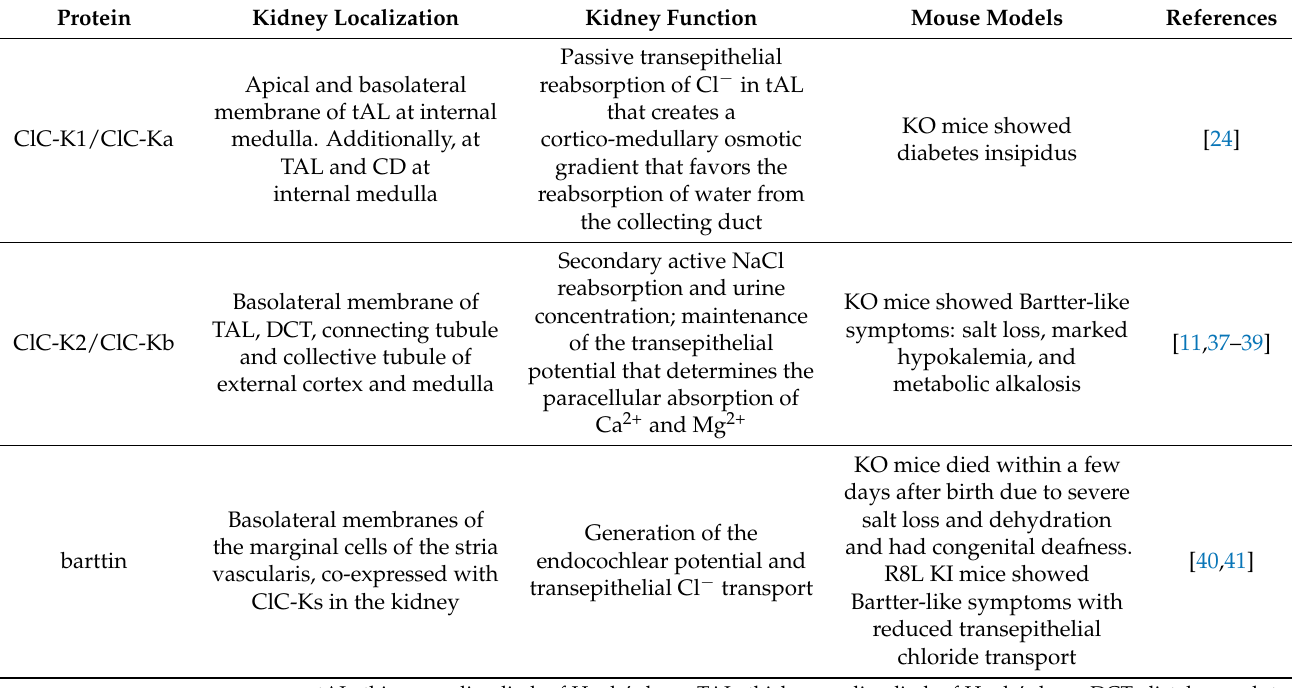
Table 1. Localization and physiological role of ClC-K channels in the kidney and inner ear as assessed from animal